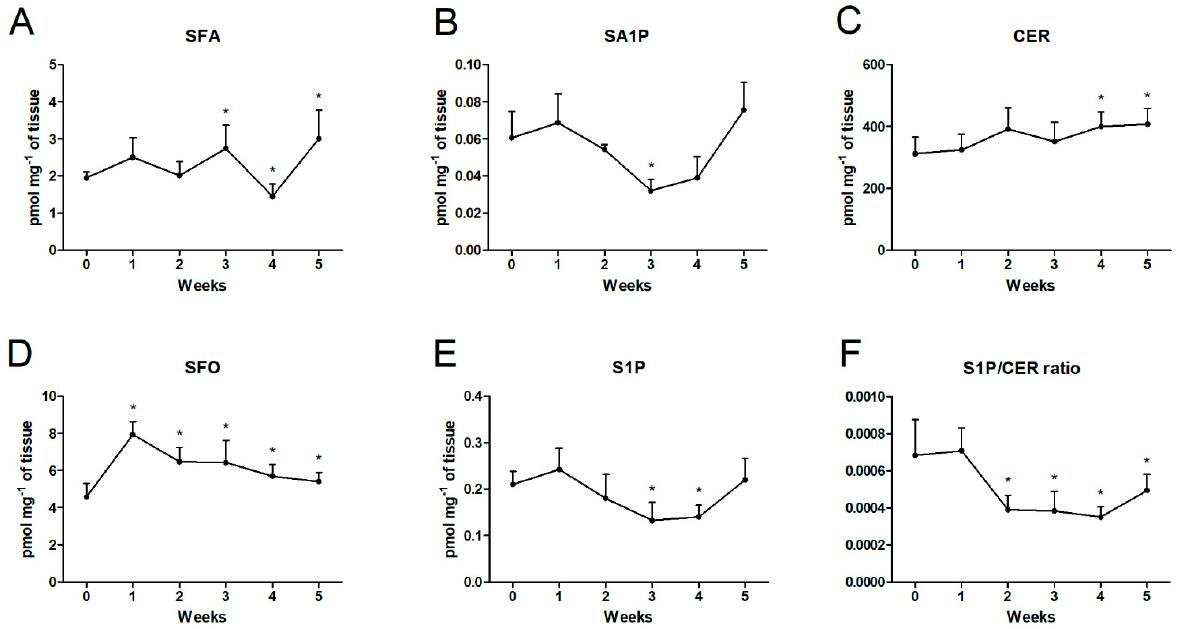
Figure 1. Liver content of sphingolipids, i.e., ( A ) sphinganine (SFA), ( B ) sphinganine-1-phosphate (SA1P), ( C ) ceramide (CER), ( D ) sphingosine (SFO), ( E ) sphingosine-1-phosphate (S1P), and ( F ) sphingosine-1-phosphate/ceramide ratio (S1P/CER ratio). The concentration of sphingolipids was determined using the high-performance liquid chromatography (HPLC). The data are presented as mean ± SD and based on n = 6 rats per group in each week of the high-fat diet (HFD). * p < 0.05 significant difference vs. control group (0 week).